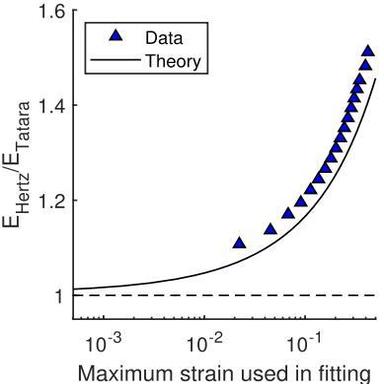
The ratio between elastic moduli obtained by fitting the Hertz and the linear Tatara model using different maximum strains. The data correspond to capsule type: Ltg.